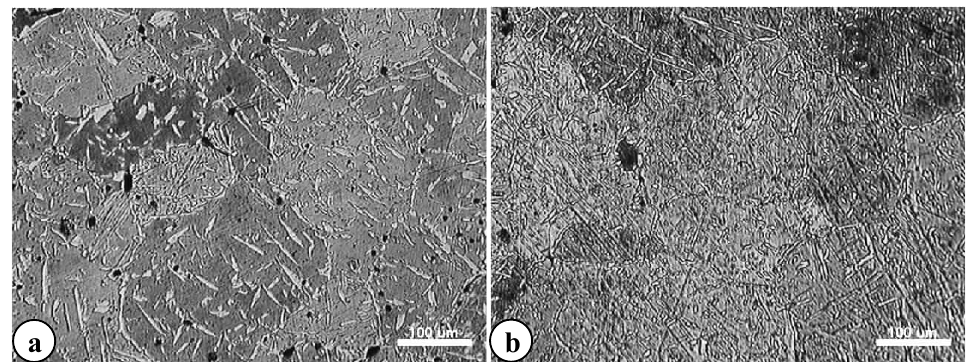
Figure 3. Microstructure of the specimens (a) sand casting (b) centrifugally casting.